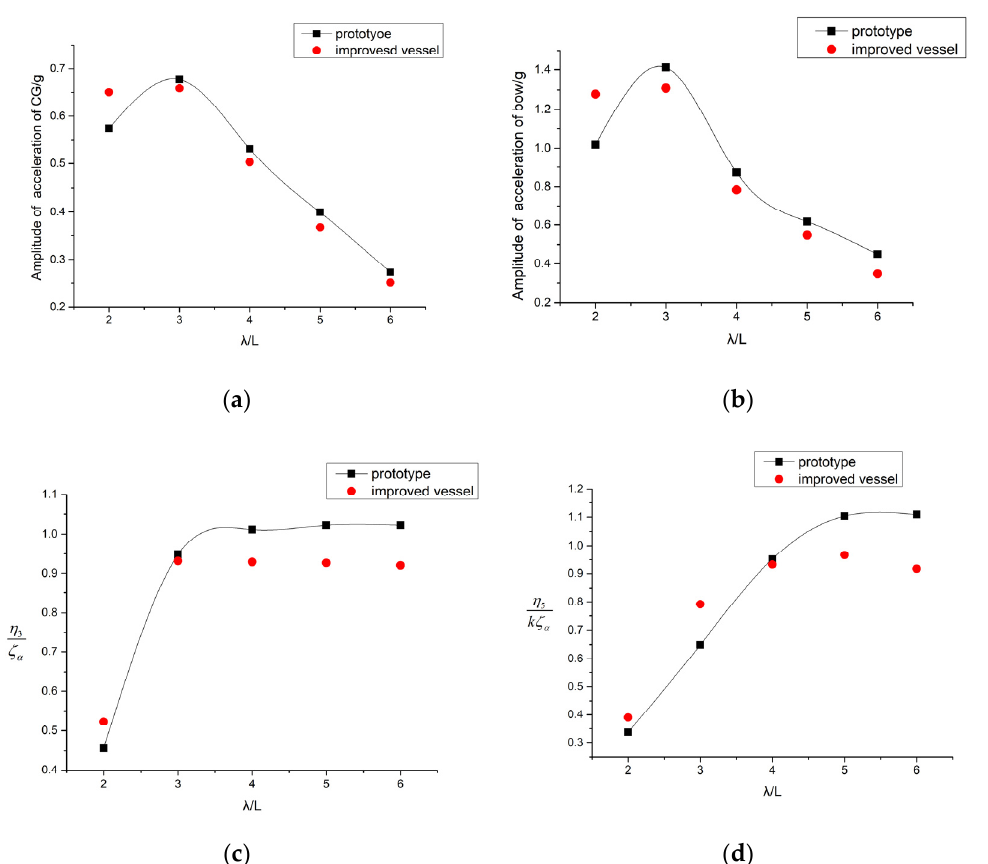
Figure 16. The comparison of the RAOs of the prototype and improved vessel: ( a ) Amplitude of the acceleration of the CG; ( b ) Amplitudes of the acceleration of the bow; ( c ) Amplitudes of the heave; ( d ) Amplitudes of the pitch.